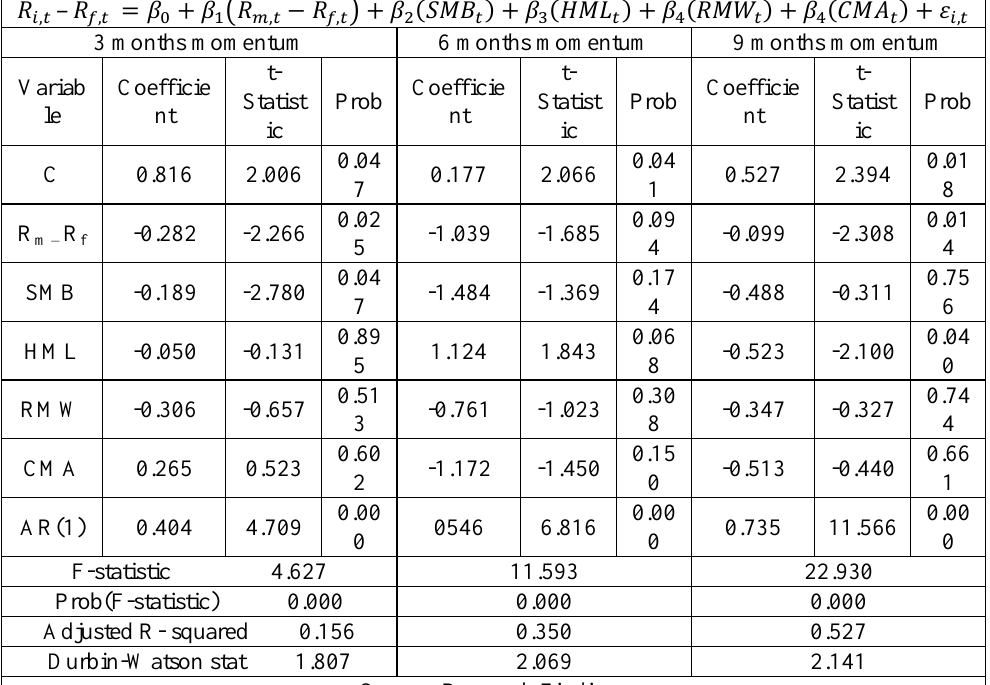
Table 8. Results of testing the third research hypothesis using the Fama-French model (